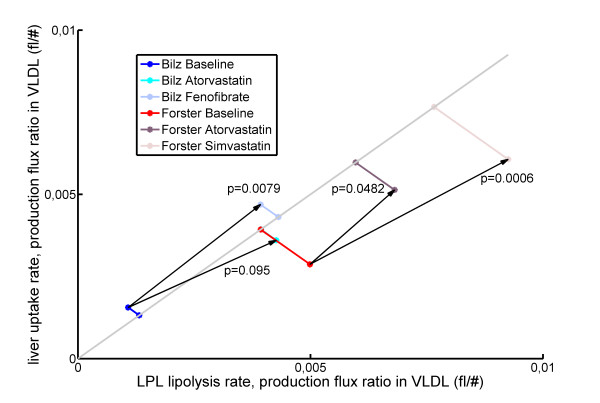
VLDL performance response to treatment. Average VLDL performance response (on identity line) to Atorvastatin, Simvastatin and Fenofibrate treatment in mixed hyperlipidemic patients [24,25]. P-values for VLDL performance were calculated by the Wilcoxon rank-sum test. Bilz Atorvastatin: n = 5, p = 0.0925; Bilz Fenofibrate: n = 5, p = 0.0079; Forster Atorvastatin: n = 9, p = 0.0482; Forster Simvastatin: n = 11, p = 0.0006. All treatments caused VLDL performance to move towards healthier values.